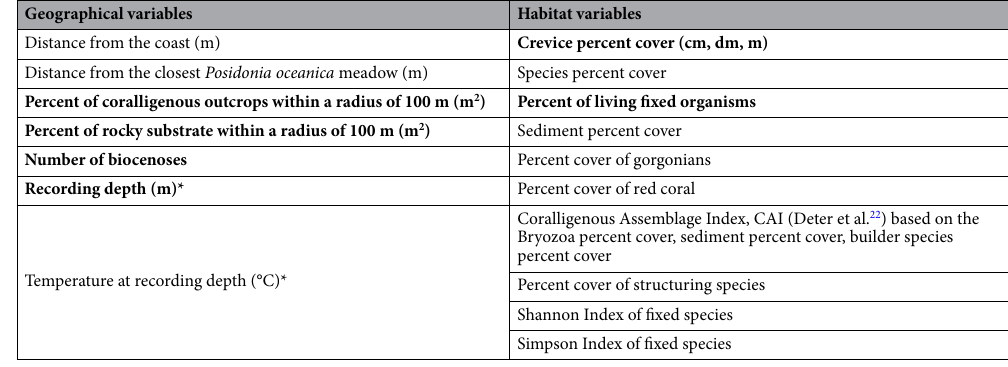
Table 1. List of geographical and habitat variables tested as drivers of coralligenous acoustic fish communities extracted from the Medtrix platform (www.medtrix.fr, RMC Water Agency/Andromède Océanologie). Descriptions of the habitat variables from the field stations are available in Deter et al. 2012. Variables selected by the model-building process for the canonical correspondence analysis are highlighted in bold. *Environmental rather than geographical variable.